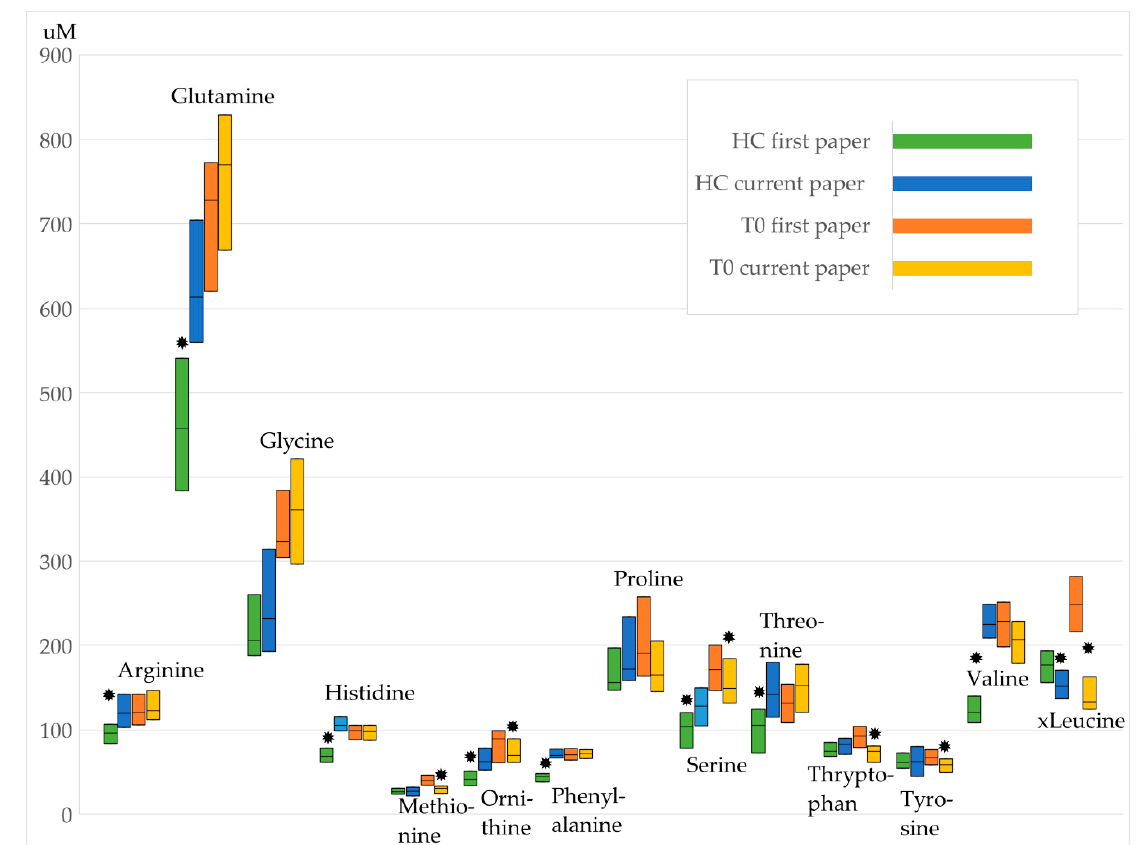
Figure 4. Concentration levels of amino acids as boxplots (25th, 50th, and 75th percentile). Values differ between first and current study: * Mann-Whitney-test p < 0.05. The non-normal distribution of concentration levels is illustrated in the Supplementary Figure S1 by violin plots for every amino acid.